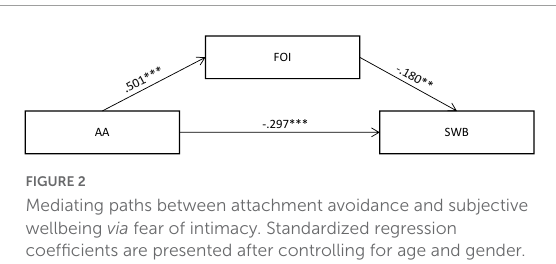
FIGURE2 Mediating paths between attachment avoidance and subjective wellbeing via fear of intimacy. Standardized regression coefficients are presented after controlling for age and gender. ∗∗∗ p < 0.001, ∗∗ p < 0.01, ∗ p <